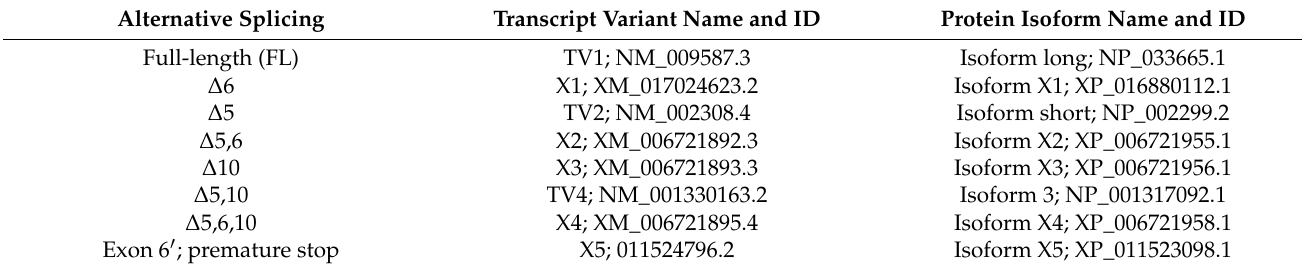
Table 1. Overview of TVs and isoforms of GAL-9 with NCBI gene database ID. Alternative